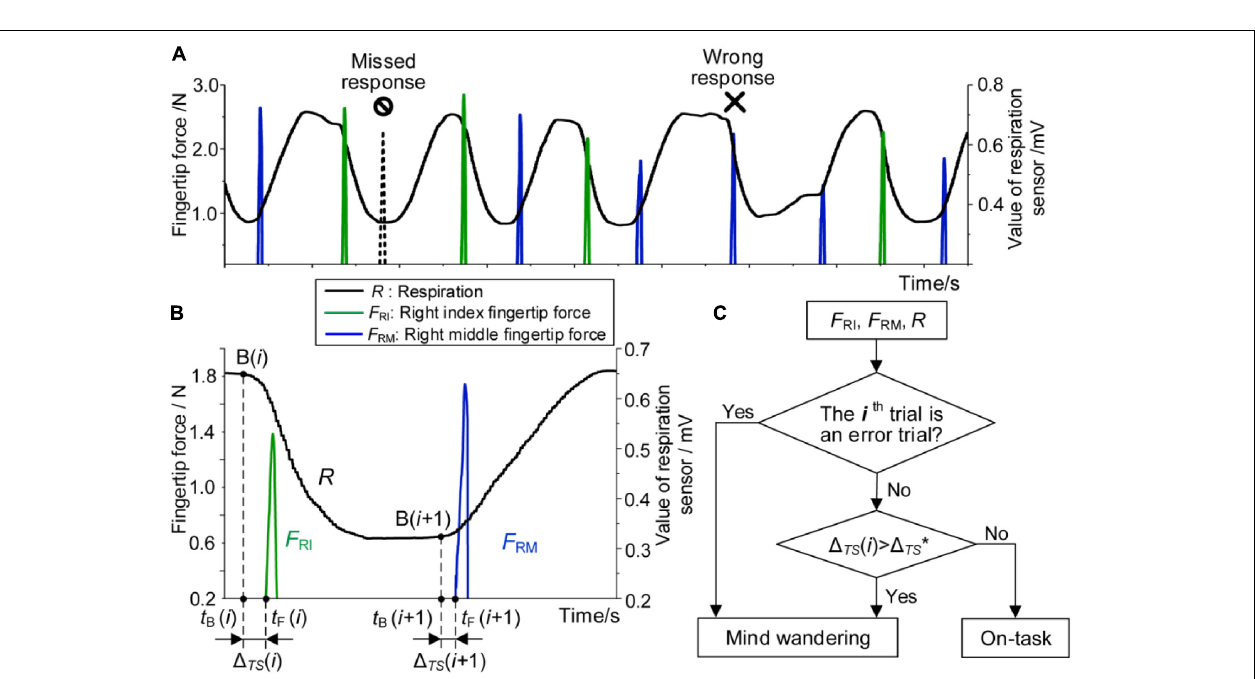
FIGURE 2 | (A) Definition of error trials, including missed response and wrong response. (B) (cid:49) TS in two consecutive trials. (C) Model of detecting mind wandering. Error trials and correct trials with (cid:49) TS values larger than (cid:49) TS ∗ were considered “mind wandering.” Correct trials with (cid:49) TS values smaller than (cid:49) TS ∗ were considered “on-task.” (cid:49) TS ∗ was the median of (cid:49) TS for all correct trials in each